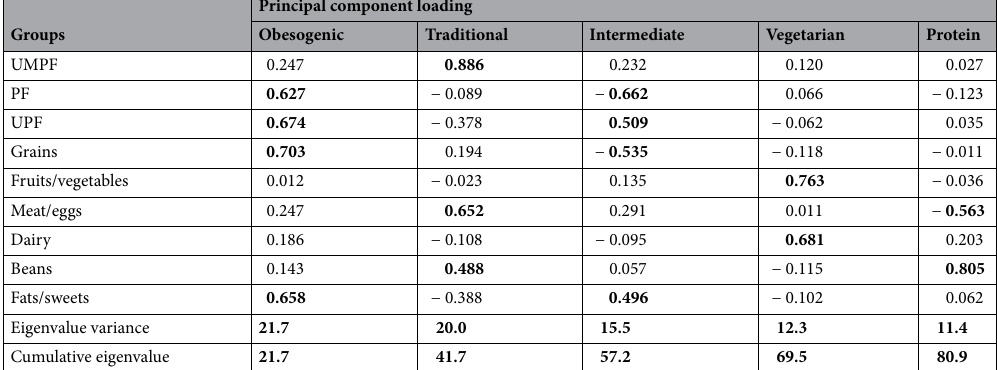
Table 3. Factor loadings of food groups in the principal dietary components obtained using PCA. PCA principal component analysis. Result of the extraction of principal components, relabeled according to the characteristics of dietary patterns and scores. In boldface, loads ≥ 0.40 (negative and positive), contribute to the creation of each component. UMPF Unprocessed and minimally processed food, PF processed food, UPF ultra-processed food, Grains foods rich in carbohydrates. Fruit/Vegetables fruits, leaves and vegetables, Dairy cheese, milk and yoghurt, Meat/eggs eggs and animal-derived meat, Beans beans, soy and peas, Fats/Sweets fats and sugar. Eigenvalue variance represented the percentage of each diet pattern and cumulative represents the sum of eigenvalues of dietary